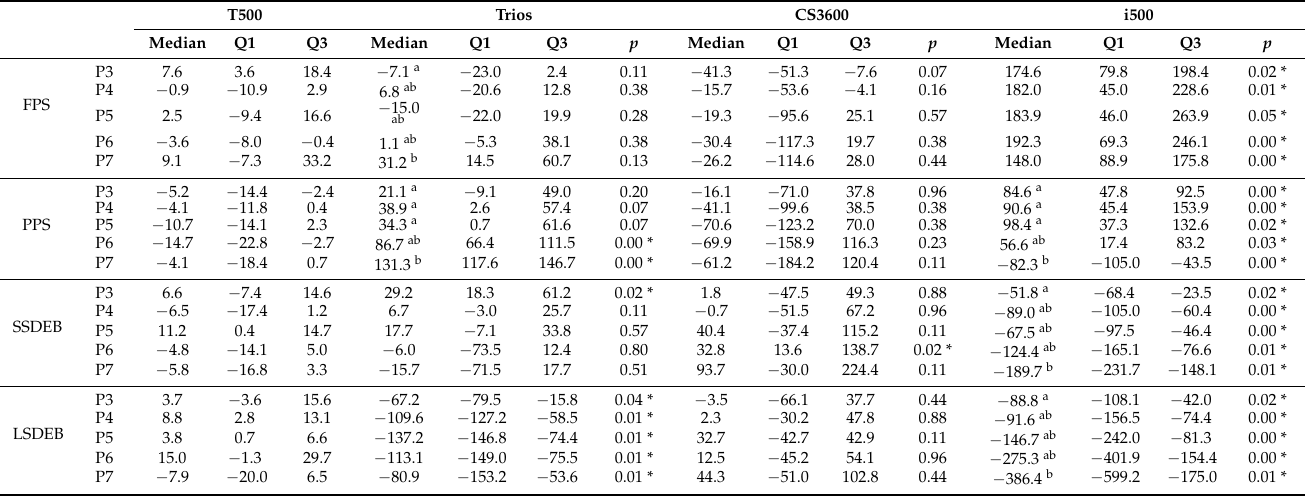
Table 2. The signed difference of experimental models (FPS, PPS, SSDEB, LSDEB) by the various scanner (T500, Trios, CS3600, i500). IQR (Median, Q1, Q3) of RMS values are presented in micrometers. IQR: Inter Quartile Range, RMS: Root Mean Square, FPS: Full Posterior Support, PPS: Partial Posterior Support, SSDEB: Short Span Distal Extension Base, LSDEB: Long Span Distal Extension Base, P3 to P7: Position 3 to Position